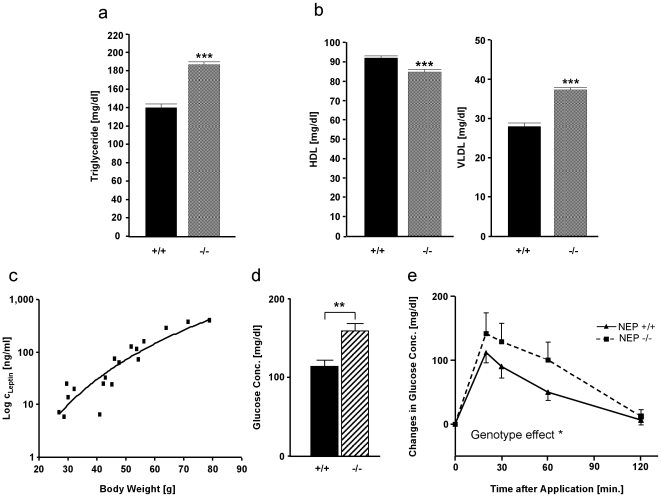
Biochemical parameters in obese NEP-deficient mice under low fat diet.(a) Serum triglycerides in one-year old NEP-deficient animals (−/−) and their age-matched wild-type controls (+/+). Student's t-test ***P<0.001 versus wild-type. (b) Serum HDL (left panel) and VLDL (right panel) in both genotypes. Data is presented as means ± SEM. Student's t-test ***P<0.001 versus wild-type. (c) Significant correlation of serum leptin levels in NEP-deficient mice with increasing body weight (r2 0.92 [Pearson correlation]). (d) Comparison of basic glucose values (before glucose tolerance test) in plasma of NEP-knockout mice with wild-type animals. Student's t-test **P<0.01 versus wild-type. (e) Comparison of NEP-knockout mice (dotted line) with wild-type animals (solid line) in their response on a glucose tolerance test. Treatment differences are calculated by two-way ANOVA *P<0.05.